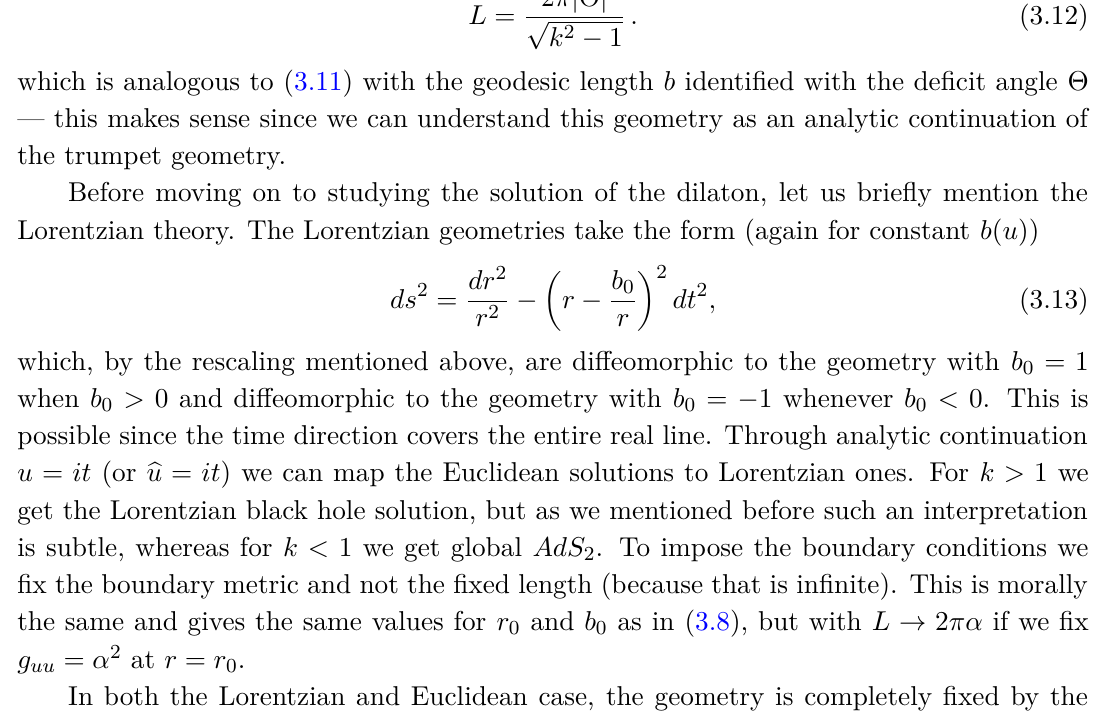
boundary in the middle and uu